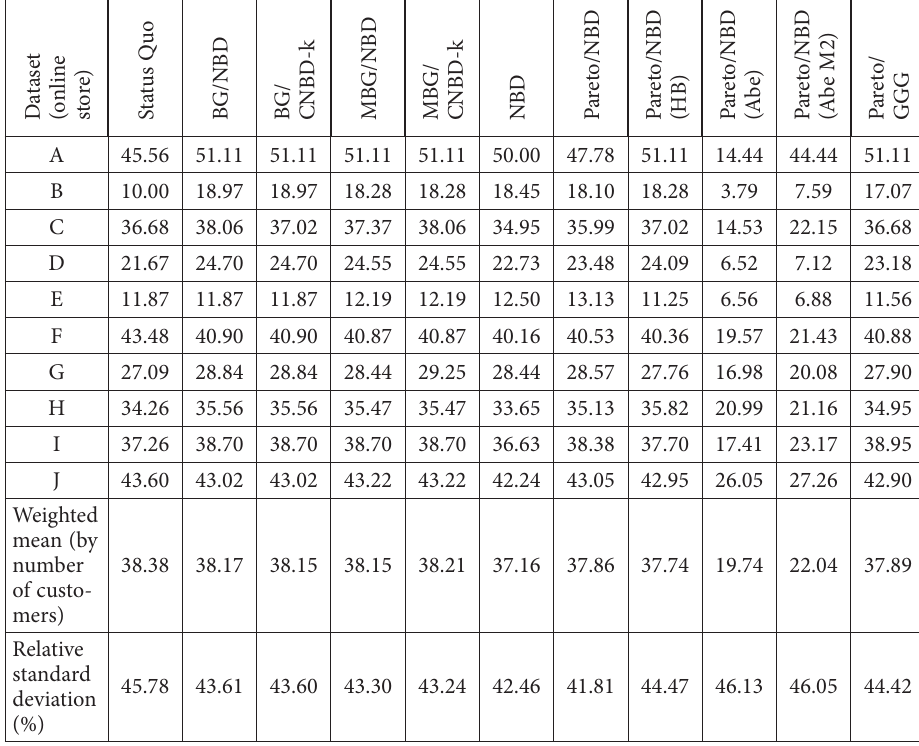
Table 6. Results for Sensitivity of selecting 1% of the most profitable customers (customer level, in %)